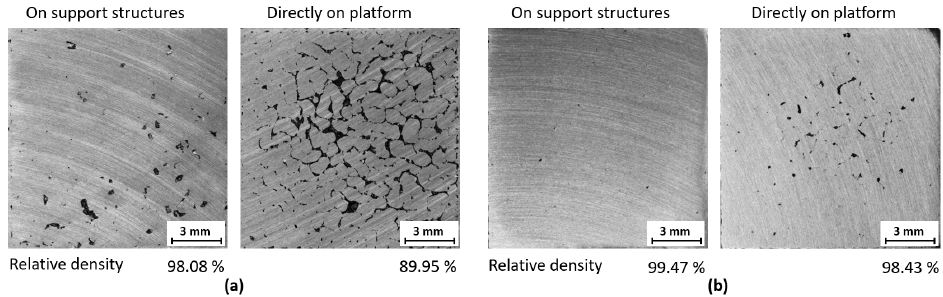
Figure 12. Influence of support structure; ( a ) Meander strategy; ( b ) Chessboard strategy.